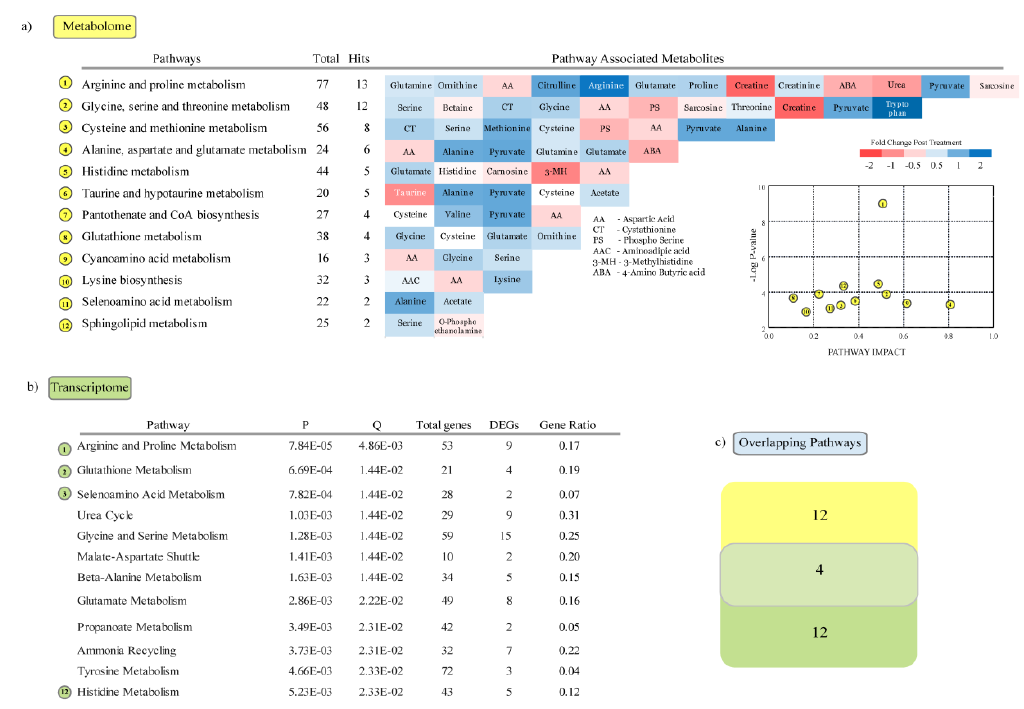
Figure 6. Metabolic pathways altered in the female group: ( a ) Metabolic pathway enrichment analyses of metabolites enriched in response to heat stress. ( b ) Metabolic pathway enrichment analyses of genes differentially expressed in response to heat stress. ( c ) Number of overlapping pathways enriched with DEGs and significantly differing metabolites in the heat stress group.